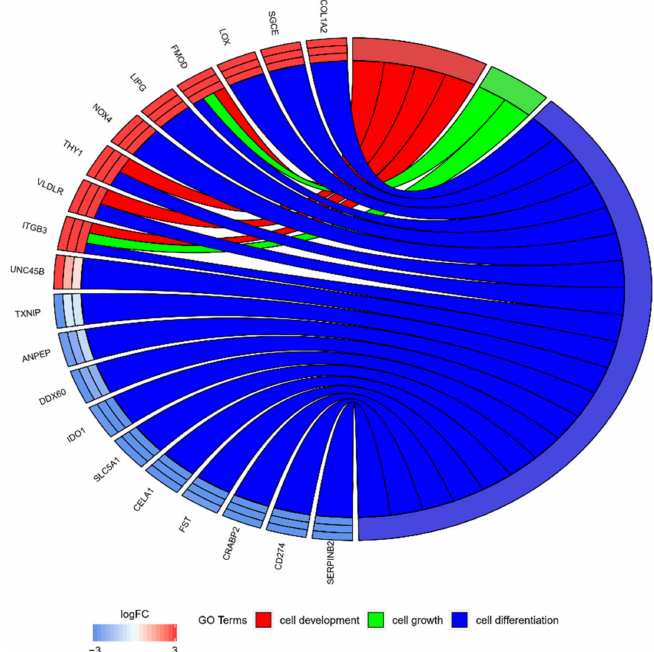
Figure 4. The representation of the mutual relationship 10 most upregulated and 10 most down- regulated genes that belongs to the “cell differentiation”, “cell growth”, “cell maturation” and “cell development” GO BP terms as well as “signaling pathways regulating pluripotency of stem cells” KEGG pathway. The bands represent what gene was included in exactly which ontology group. LogFC (logarithm from fold change) between each culture day (7/1; 15/1; 30/1) respectively is shown as the middle circle. The order of genes presented was selected based on logFC and represents from strongest to weakest